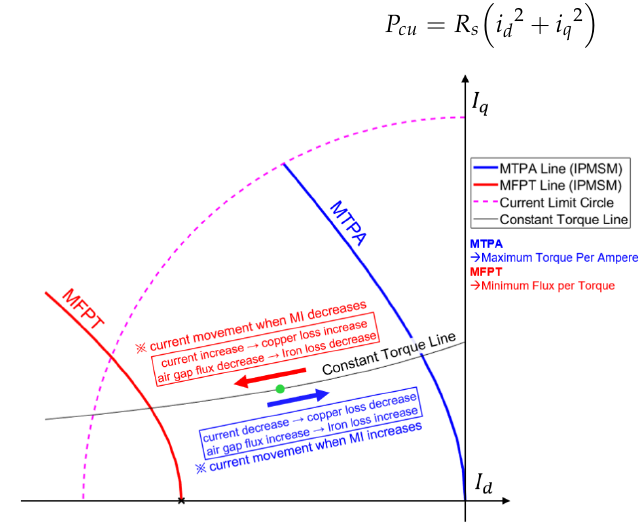
Figure 1. The tendency of power loss to change due to the movement of the current operating